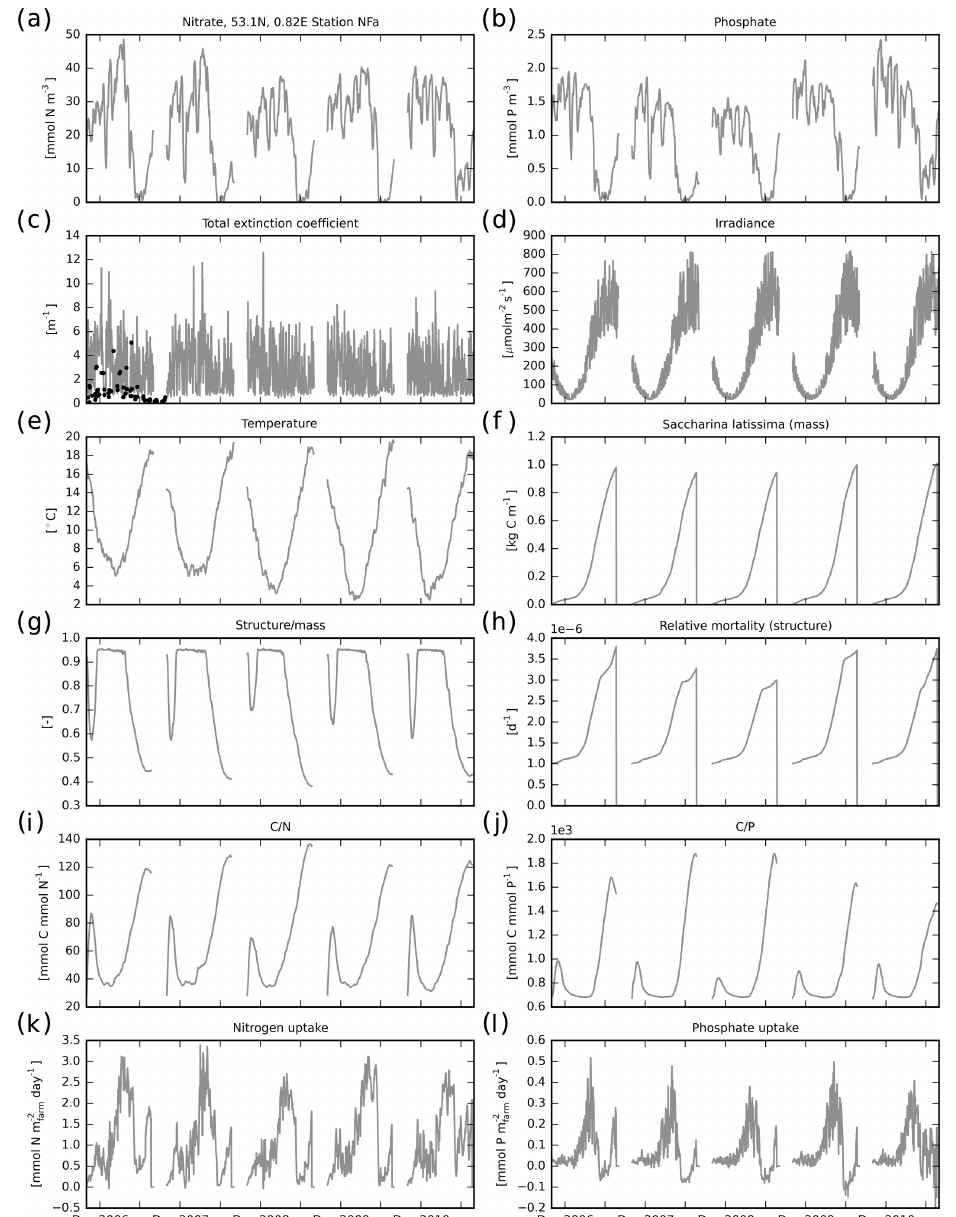
Figure 13. Model results for the western-most grid cell of the north Norfolk farm site. (a) Surface nitrate concentration; (b) surface phosphate concentration; (c) total extinction coefficient at the surface (excluding contribution by macroalgae); (d) irradiance at the surface; (e) surface water temperature; (f) macroalgae carbon biomass per metre of line; (g) mass of macroalgae structure over total macroalgae mass ratio; (h) relative mortality of macroalgae structure; (i) C / N ratio of macroalgae; (j) C / P ratio of macroalgae; (k) farm net nitrogen uptake; (l) farm net phosphate uptake. Black dots in panel (c) are the k d contribution by SPM, calculated from in situ SPM samples collected in the years 1996–2000 using the relationship derived by Devlin et al. (2009) and projected onto